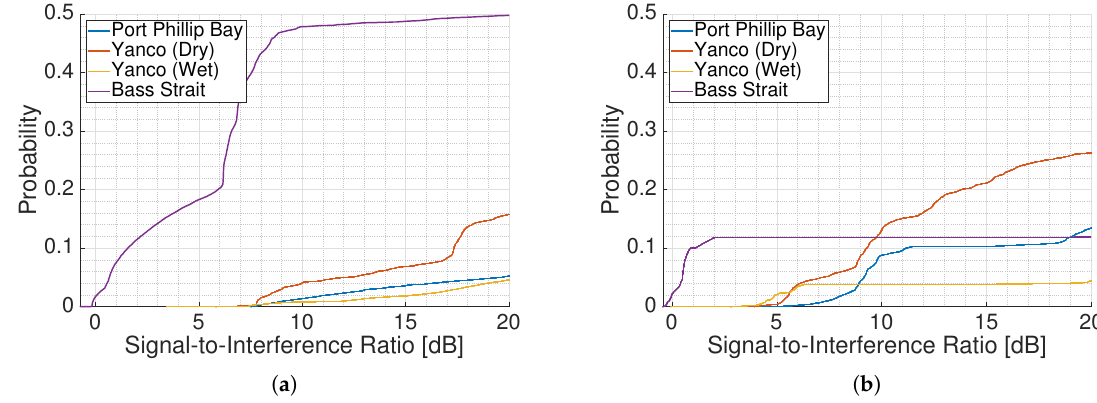
Figure 5. Cumulative histogram of the probability of having cross-talk in the ( a ) L1/E1 and, ( b ) L5/E5a frequency bands for the different MIR